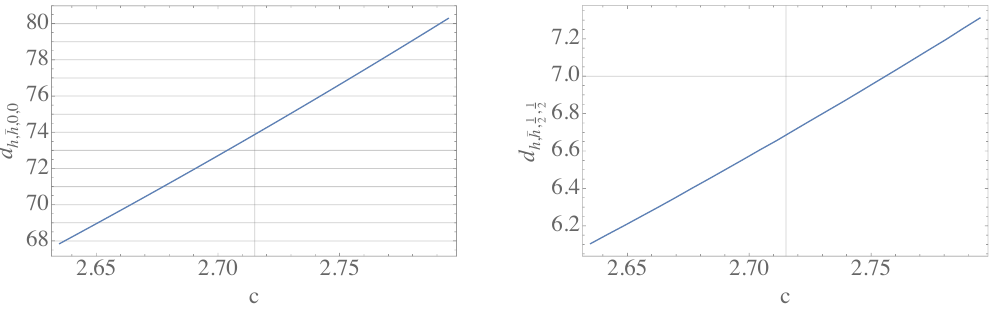
Figure 16 . Occupation numbers for the lightest neutral (left) and charged (right) states from the extremal functional analysis with SU(2) at k = 2 as a function of c . The optimal bound is at c (cid:25) 2 : 715, indicated by a vertical line; horizontal lines are shown at integers. Since Q span a ( d + 1 = 2 (cid:14) (cid:0) 1) dimension space it means only the diagonal 2 2 2